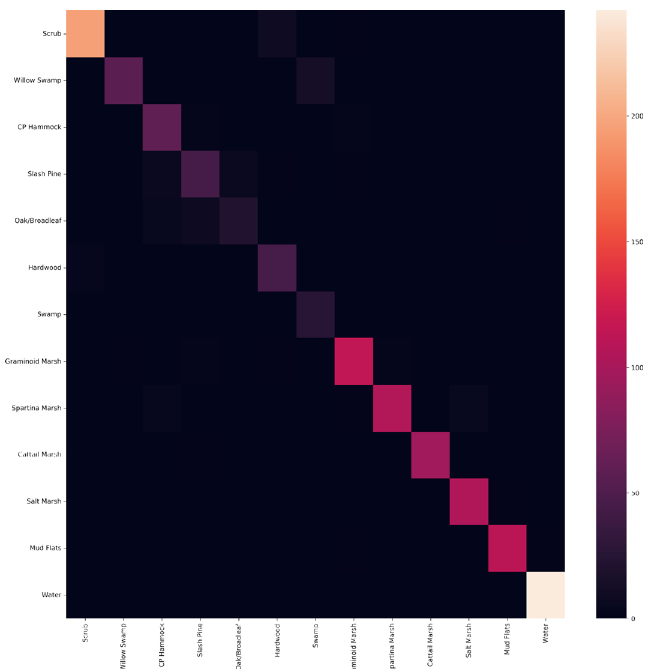
Fig. 12 Kennedy Space Center Confusion Matrix for PCA 30 CEU-Net no patching with a 75%/25% Training/ Testing split